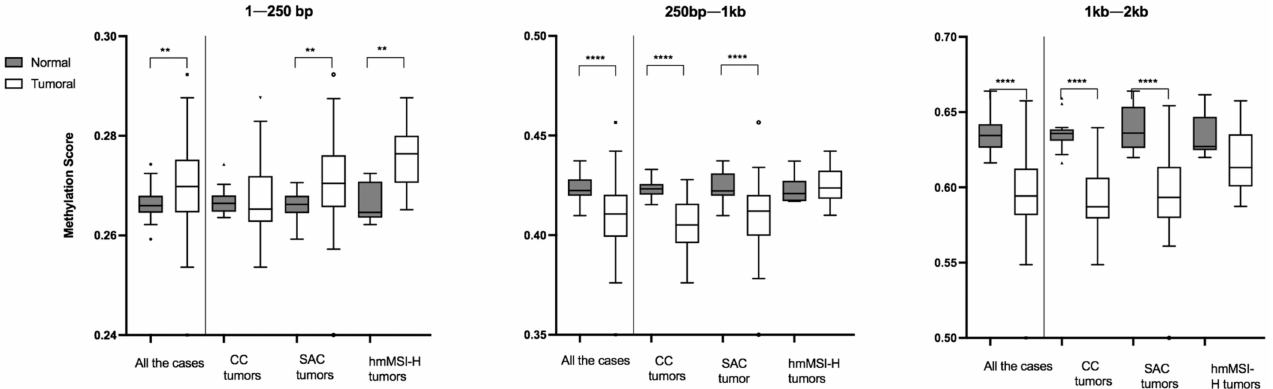
Figure 1. Comparison of global methylation scores between normal and tumor specimens for each tumor histological subtype. CC: conventional carcinoma, SAC: serrated adenocarcinoma, hmMSI-H: colorectal cancer showing histological and molecular features of high level of microsatellite instability, ** p < 0.01, **** p <